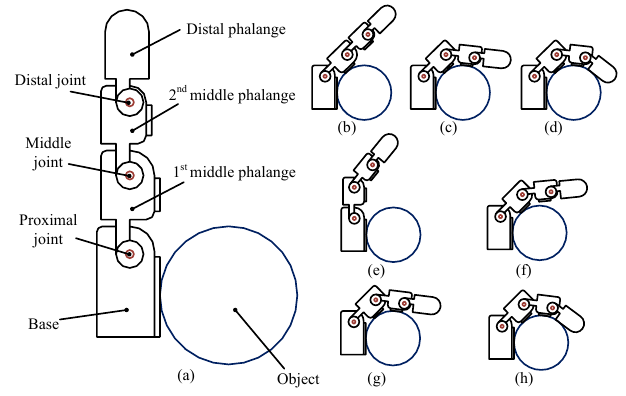
Figure 1. UA motion and PB motion of 3-joint GCUA finger. (a, b, c, d) UA motion; (a, e) PB motion; (f, g, h) UA motion with Fig. 1 UA motion and PB motion of 3-joint GCUA finger. a,b,c,d) UA motion; a,e) PB motion; the changed initial gesture; (a) Initial gesture (keep straight); (b) Proximal joint rotates until 1st middle phalange touches the object; f,g,h) UA motion with the changed initial gesture; a) Initial gesture (keep straight); b) Proximal (c) Middle joint rotates until 2nd middle phalange touches the ob- joint rotates until 1 st middle phalange touches the object; c) Middle joint rotates until 2 nd middle ject; (d) Distal joint rotates until distal phalange touches the object; phalange touches the object; d) Distal joint rotates until distal phalange touches the object; e) (e) Middle joint rotates to change the finger’s initial Middle joint rotates to change the finger’s initial gesture.